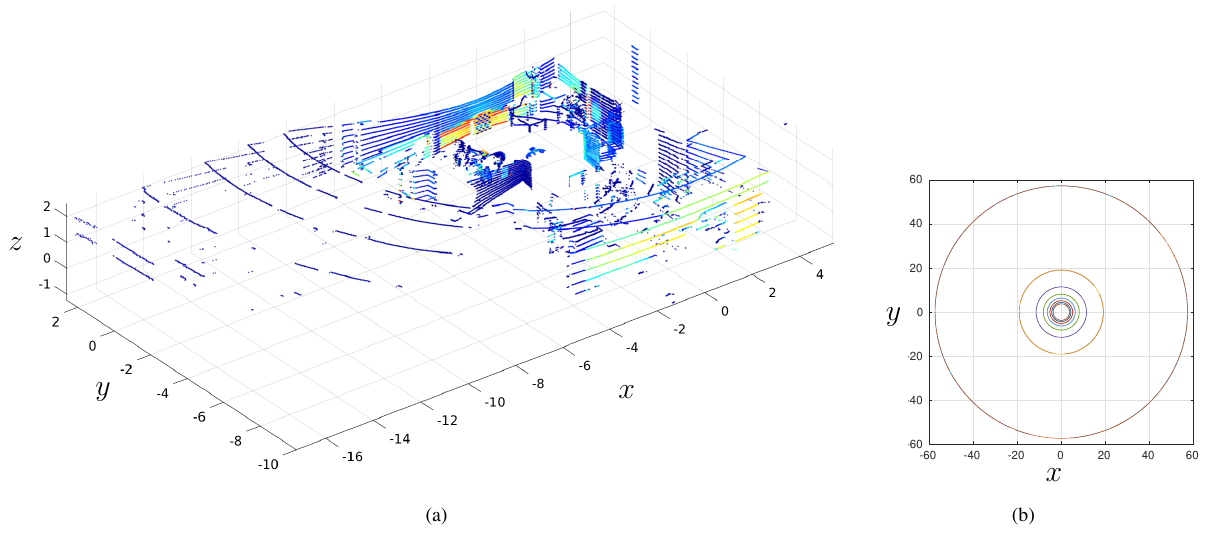
2 Figure 6. Real point cloud data from the Velodyne VLP-16 laser scanner in R (a) and in RP